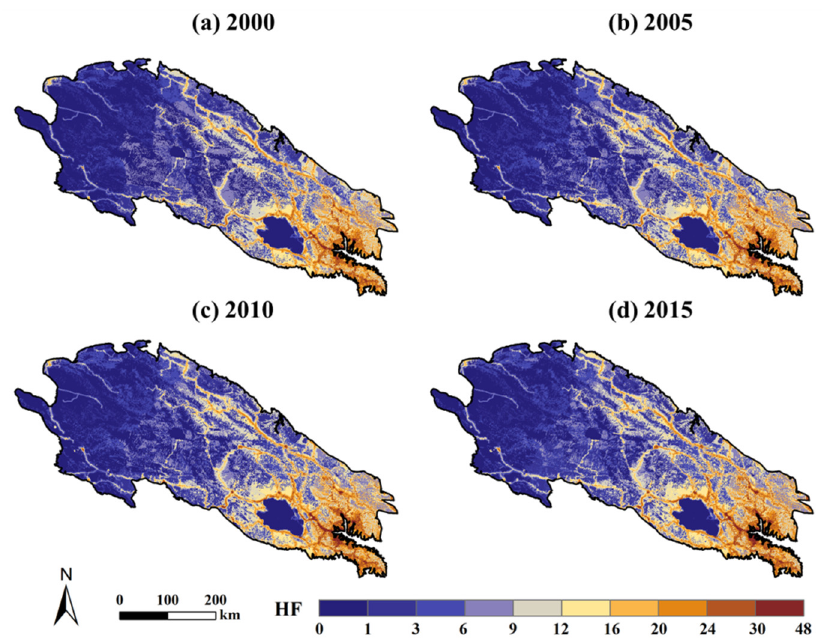
Figure 3. HF maps of the QLM from 2000 to 2015: ( a ) HF map for 2000; ( b ) HF map for 2005; ( c ) HF map for 2010; ( d ) HF map for 2015.